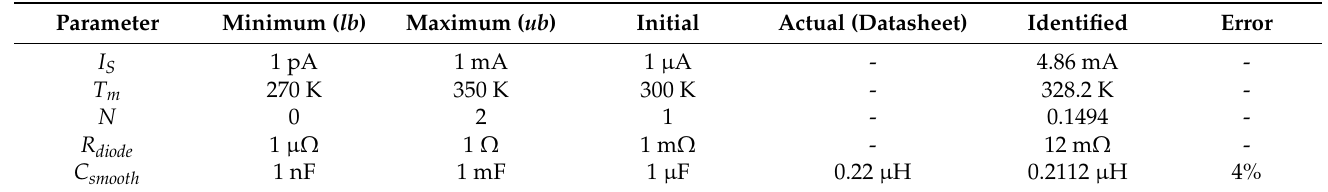
Table 3. Optimization conditions of the NLS identification algorithm of the single-phase rectifier and comparison of actual and identified parameters. Parameter